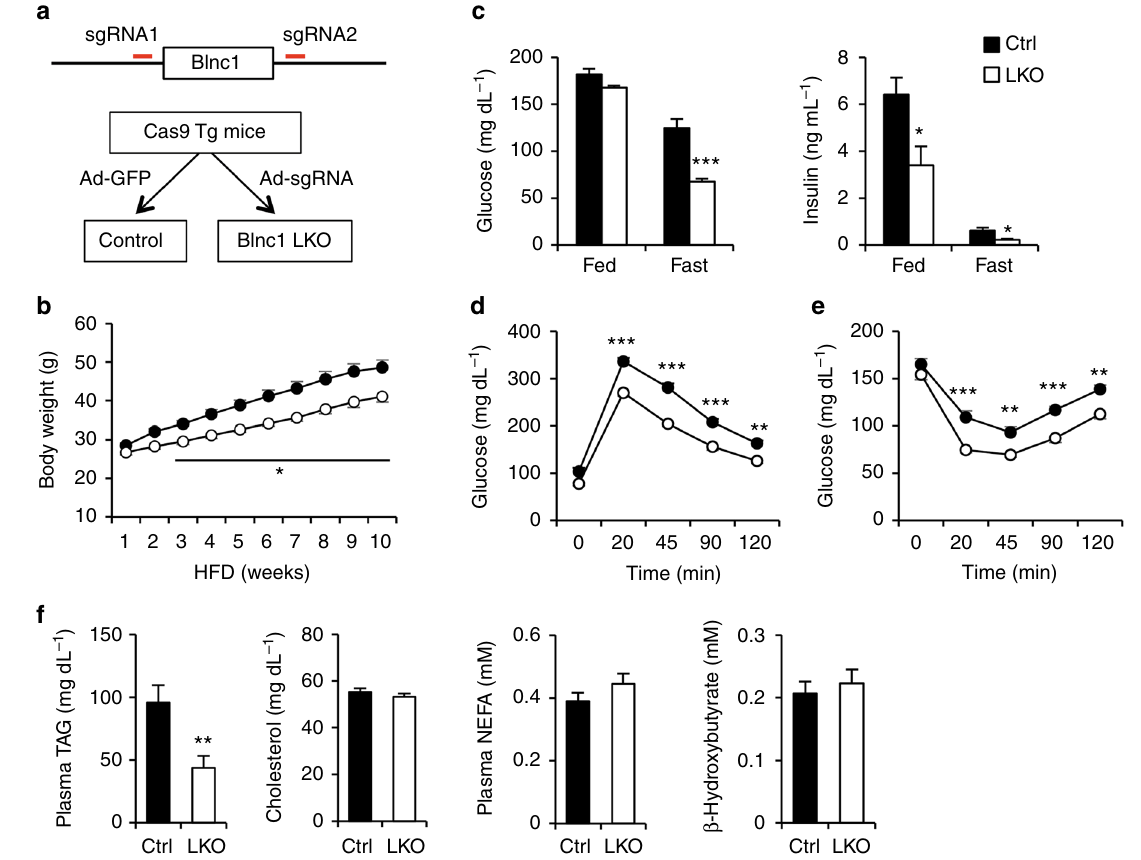
Fig. 3 Liver-speci fi c inactivation of Blnc1 alleviates diet-induced obesity. a A schematic of the strategy for the generation of Blnc1 LKO mice using CRISPR/ Cas9. Adenoviral expression of sgRNAs in Cas9 transgenic mice results in liver-speci fi c deletion of Blnc1. b Body weight of control (ctrl, fi lled, n = 8) and LKO (open, n = 11) mice fed HFD for 10 weeks. Data represent mean ± SEM. * p < 0.01, ctrl vs. LKO, two-way ANOVA with multiple comparisons. c Blood glucose (left) and plasma insulin (right) concentrations in ctrl ( n = 9) and LKO ( n = 9) mice after HFD feeding for 17 weeks (fast) and 19 weeks (fed). d , e GTT ( d ) and ITT ( e ) in ctrl ( fi lled, n = 9) and LKO (open, n = 9) mice fed HFD for 8 and 9 weeks, respectively. Data represent mean ± SEM. ** p < 0.01, *** p < 0.001; ctrl vs. LKO, two-way ANOVA with multiple comparisons. f Plasma parameters in mice fed HFD for 19 weeks. Data in ( c ) and ( f )